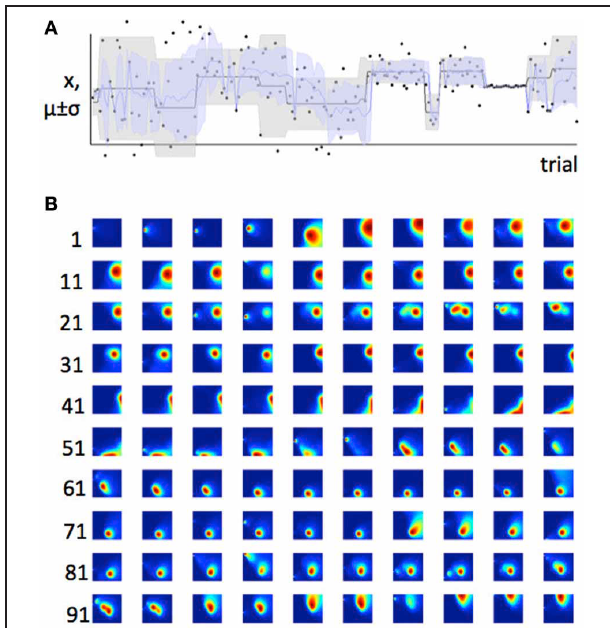
FIGURE 5 | Bayesian learner estimates the mean and variance of a Gaussian distribution. (A) Data and maximum likelihood estimates for 200 trials. The actual mean and variance of the distribution from which the data were drawn (generative distribution) are shown in gray. The gray line is the mean and the shaded area is mean ± standard deviation. The model’s estimates of these parameters are shown superposed on this, in blue. The actual data point on which the model was trained are shown as black dots. The scale on the y-axis is arbitrary. (B) The probability density function across parameter space (for plotting conventions, see Figure 3 ) for the first 100 trials. Each parameter-space map represents one trial; trials are shown in rows with the first trial number in each row indicated to the left of the row. Possible values of μ i are plotted on the y-axis; possible values of σ i are plotted on the x-axis. Colors indicate the joint posterior probability for each pair, mu, sigma, after observing data point x i . Increasing values of sigma are plotted from left to right; increasing values of μ i are plotted from top to bottom. Hence, for example on trial 10 (top right) the model thinks μ i is low, and σ i is high. Some interesting sequences of trials are highlighted in Figures 6 , 7 .